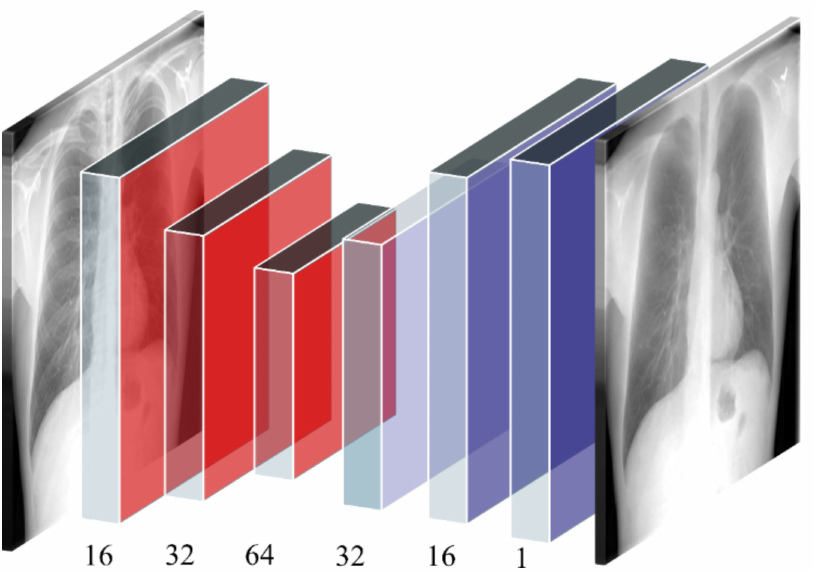
Figure 1. The architecture of the proposed AE–BS model. The AE–BS model has a symmetrical convolutional encoder (shown with red-colored boxes) and decoder (shown with blue-colored boxes)